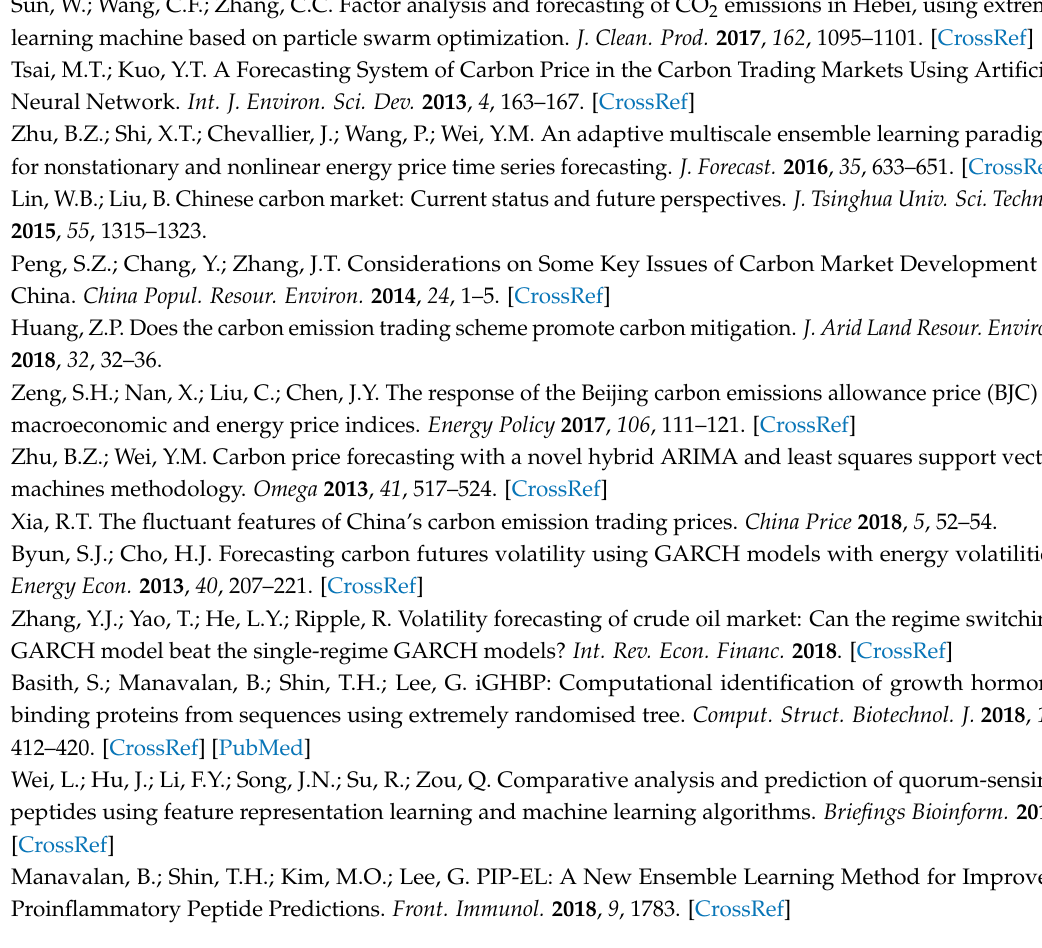
Table A10. The new subsequences divided according to the SE values.